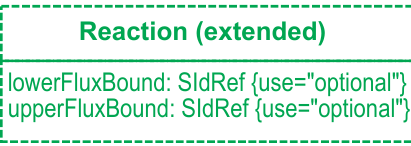
Figure 7: A UML representation of the extended SBML Reaction class used in the Flux Balance Constraints package. For a complete description see Figure 1 as well as Section 1.4 for conventions related to this figure.